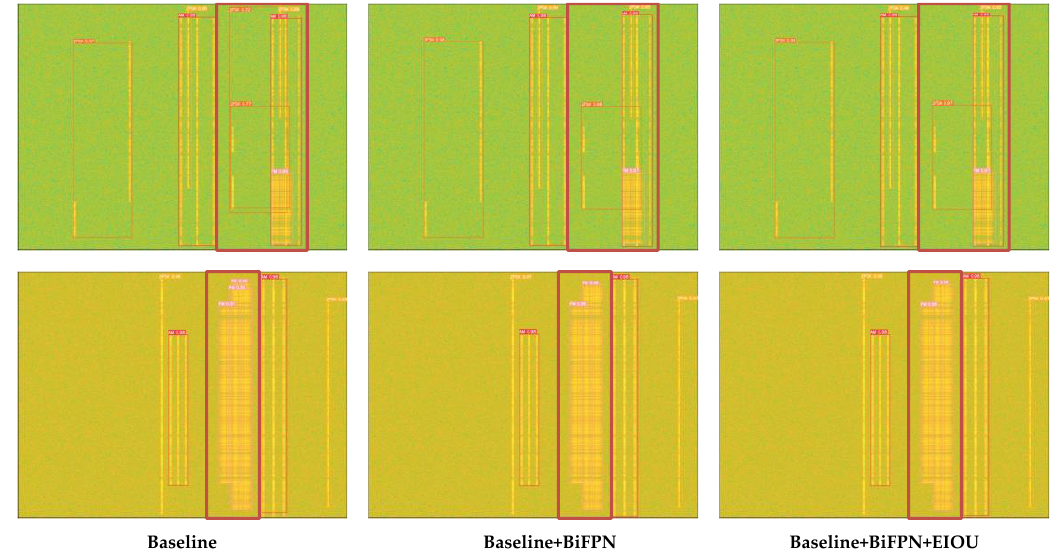
Figure 10. Comparison of the detection of different models. Table 2. Comparison of the average parameter indicators of the four